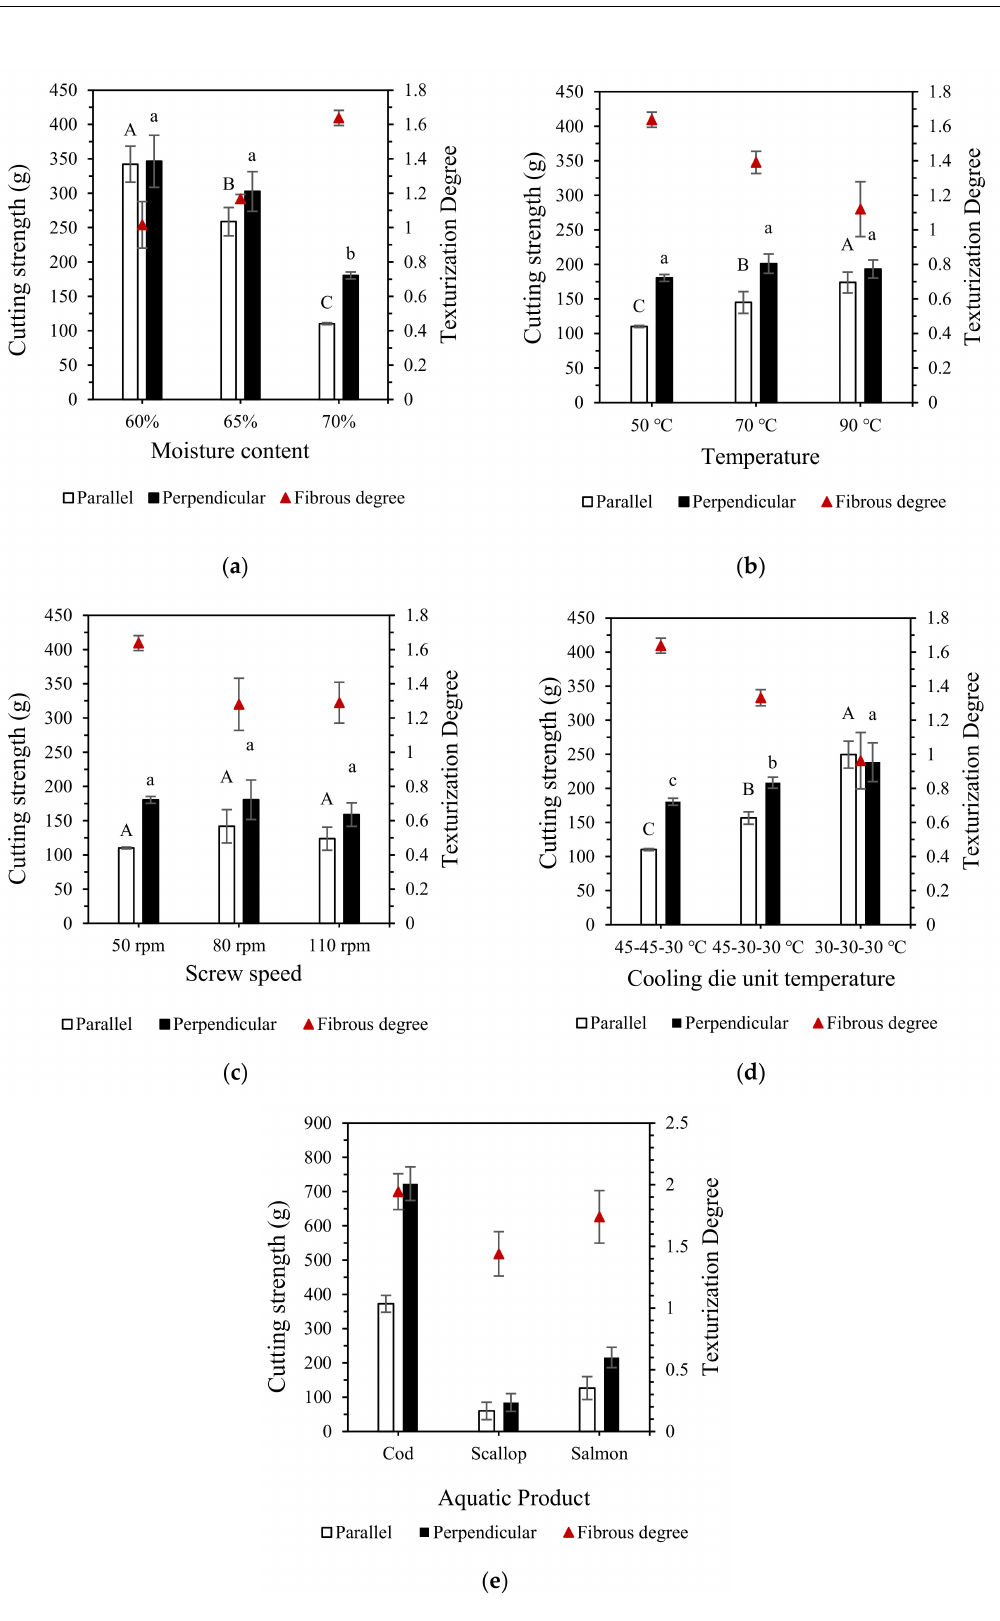
Figure 2. Cutting strength and texturization degree of the extrudates under different processing conditions as well as the three aquatic products: ( a ) moisture content, ( b ) extrusion temperature, ( c ) screw speed, ( d ) cooling die unit temperature and ( e ) aquatic product. Different letters indicate significant differences (Least Significant Difference test, p < 0.05) between mean values ( ± SD, n =